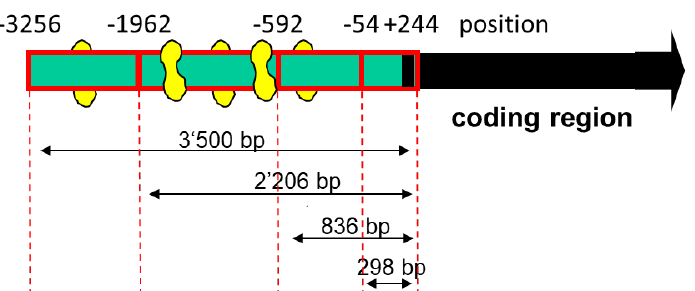
Figure 2. Diagram of the deletion analysis of the SLC22A5 gene promoter 5 ′ terminus. MEF2 binding sites are indicated in yellow. The design of the different lengths of the SLC22A5 gene promoter was based on the template of the sequenced −3 256/+244 fragment. The −1 624/ −1 595 fragment, which was used in the gel-shift competition and electrophoretic mobility shift assays, is not shown in the figure. To assess the function of the MEF2 binding sites, we produced different 5 ′ -truncated fragments of the SLC22A5 gene 5 ′ upstream region and inserted them into the pGL3